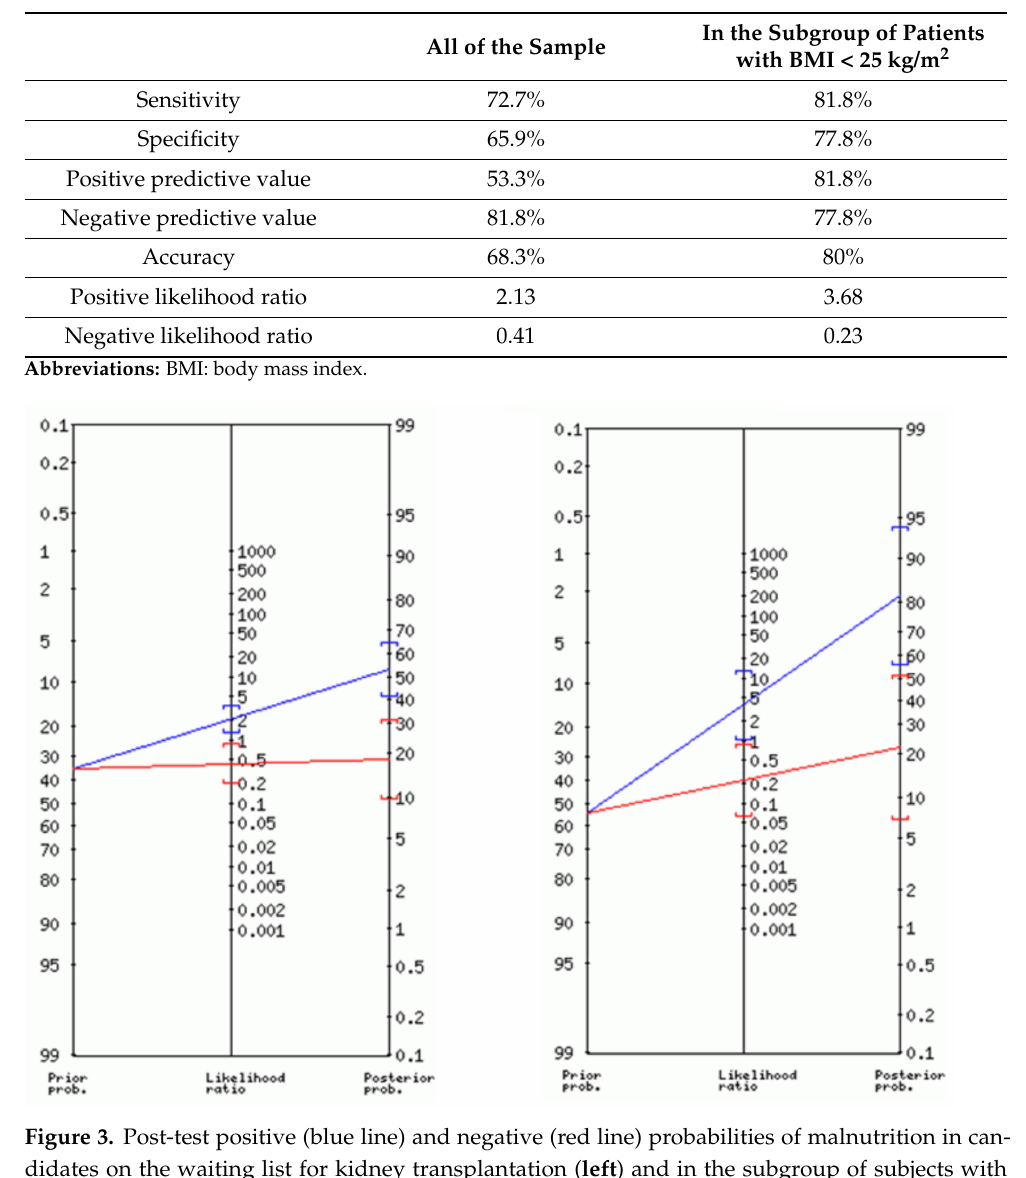
Table 3. Performance properties of the index test (reduced phase angle) to detect malnutrition accord- ing to the Global Leadership Initiative on Malnutrition (GLIM) criteria in patients with advanced chronic kidney disease on the waiting list for kidney transplantation (A), and in the subgroup of patients with body mass index <25 kg/m 2 (B).